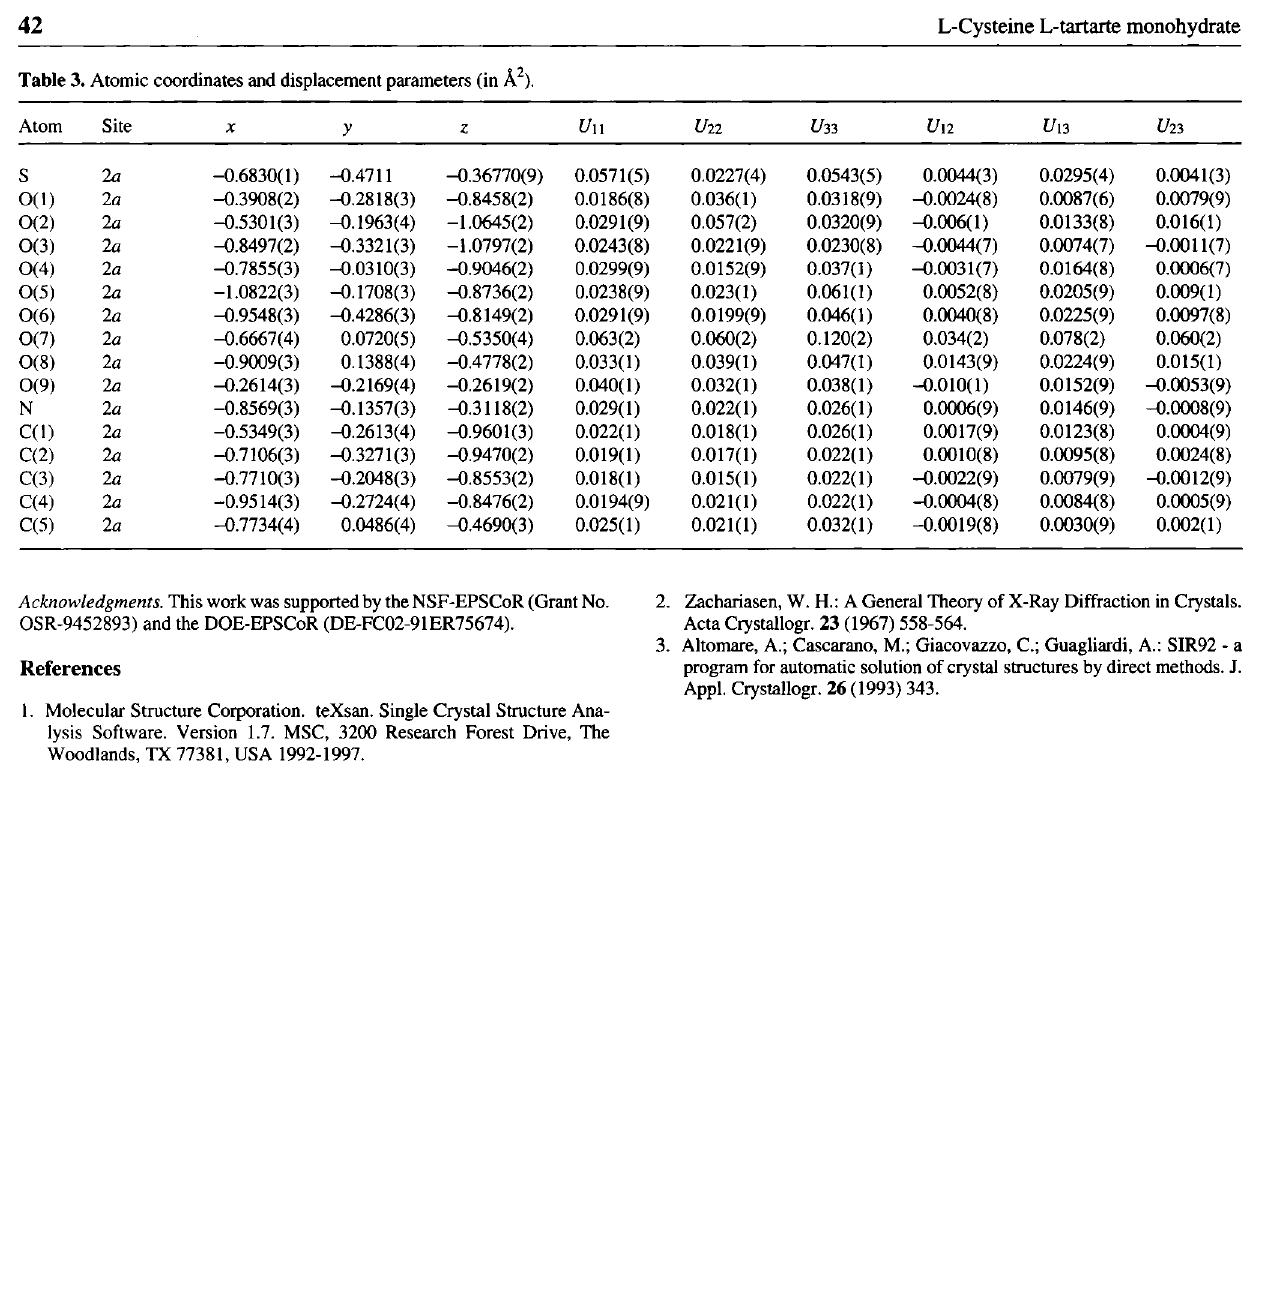
Table 3. Atomic coordinates and displacement parameters (in Â 2